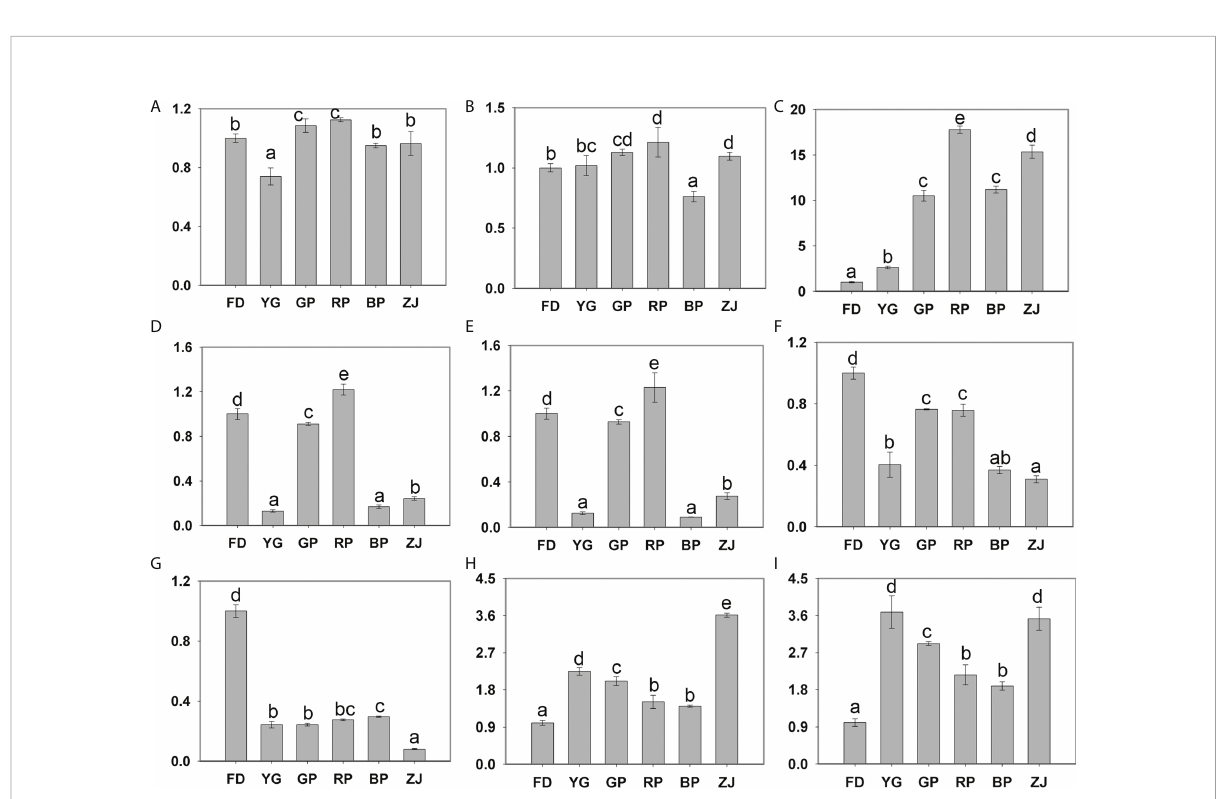
FIGURE 5 Expression of differentially expressed genes by RT-qPCR validation. (A) PAL (CSS0018870); (B) CHI (CSS0034202); (C) ANS (CSS0010687, CsANS1 ); (D) OMT (CSS0007434); (E) OMT (CSS0027035); (F) OMT (CSS0033028); (G) MYB family gene (CSS0015793); (H) MADS family gene (CSS0016295); (I) WRKY family gene (CSS0024910). Signi fi cant difference at p < 0.05 is indicated by different letters (a – e) above the